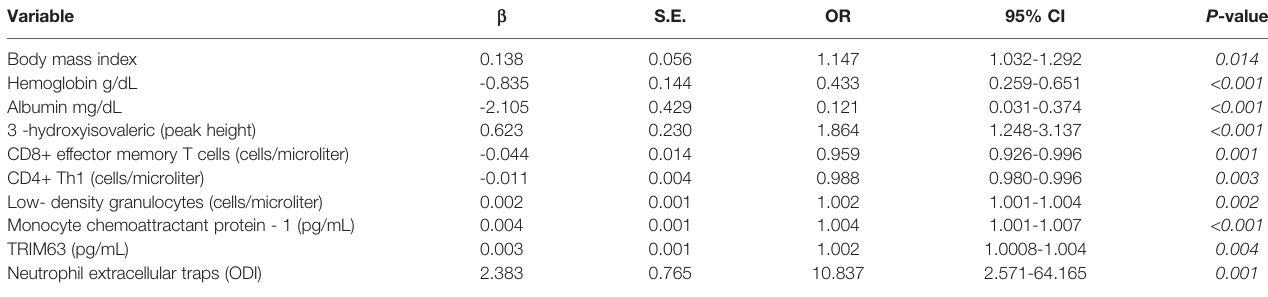
TABLE 5 | Variables associated to COVID-19 severity included in the selected model.